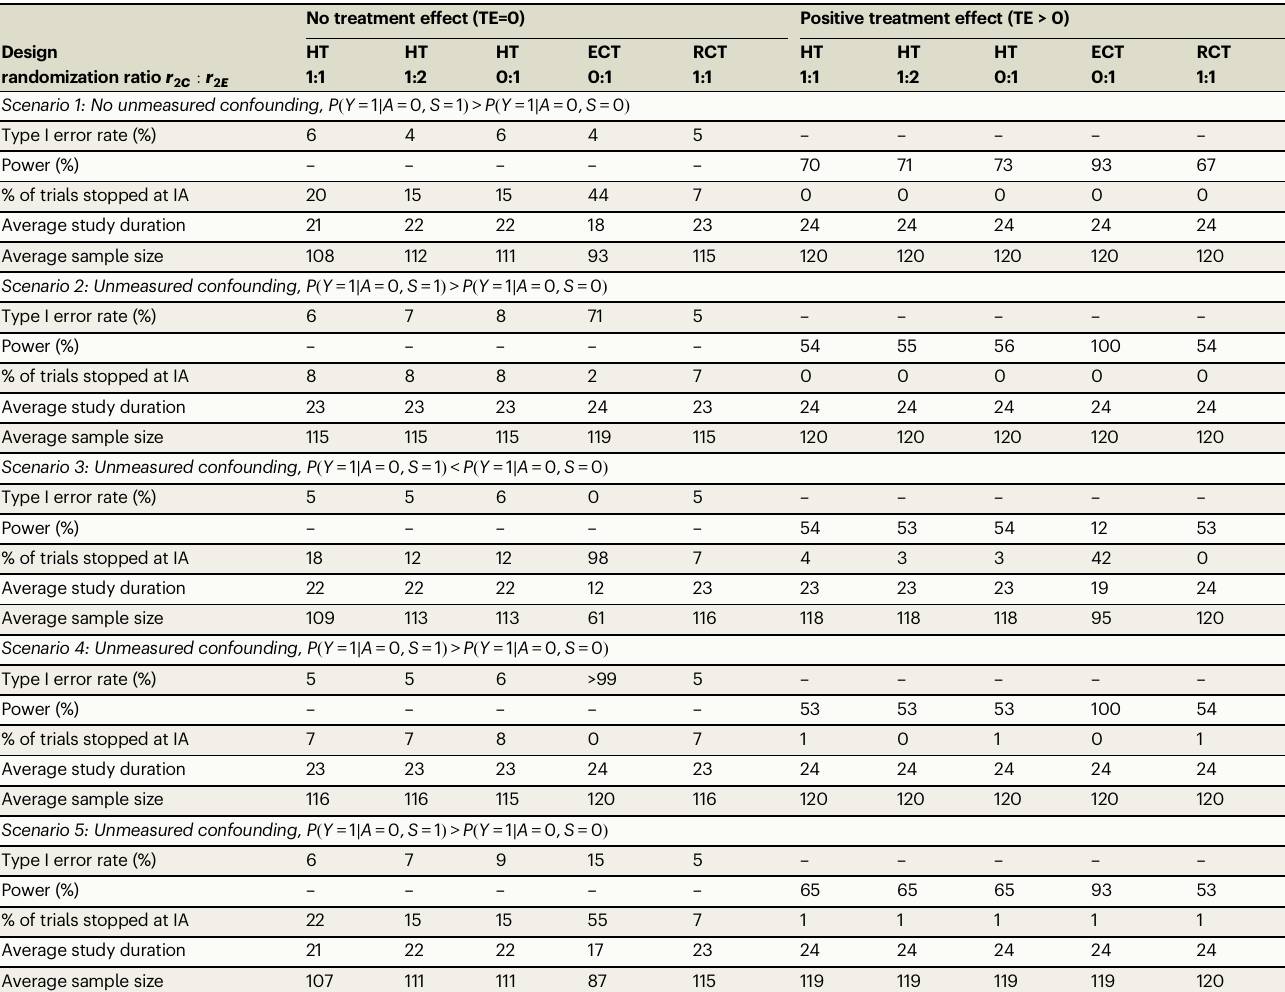
Table 2 | Operating characteristics of the HT, ECT and RCT